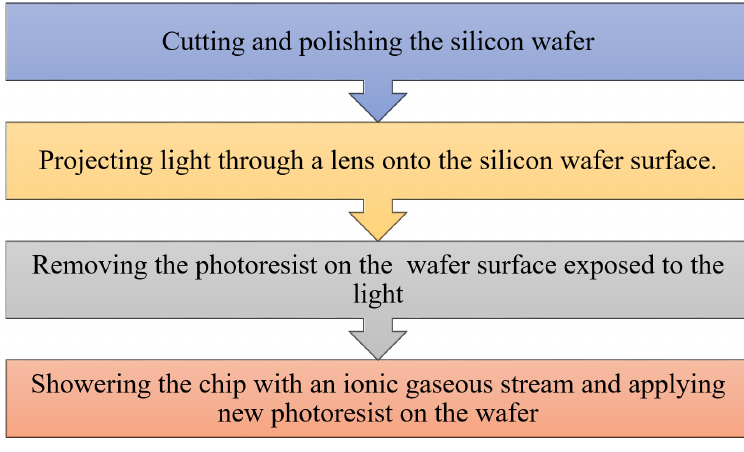
Figure 1. Procedure of a semiconductor manufacturing process.